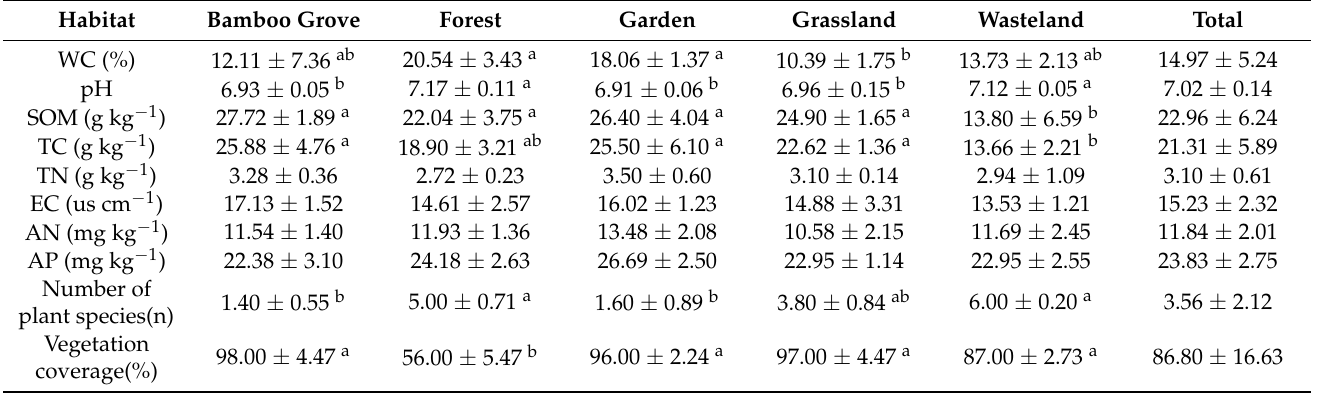
Table 2. Soil properties and vegetation in different habitats (mean ± S.D.). Note: different letters in each row mean significant differences while no mark means no significant